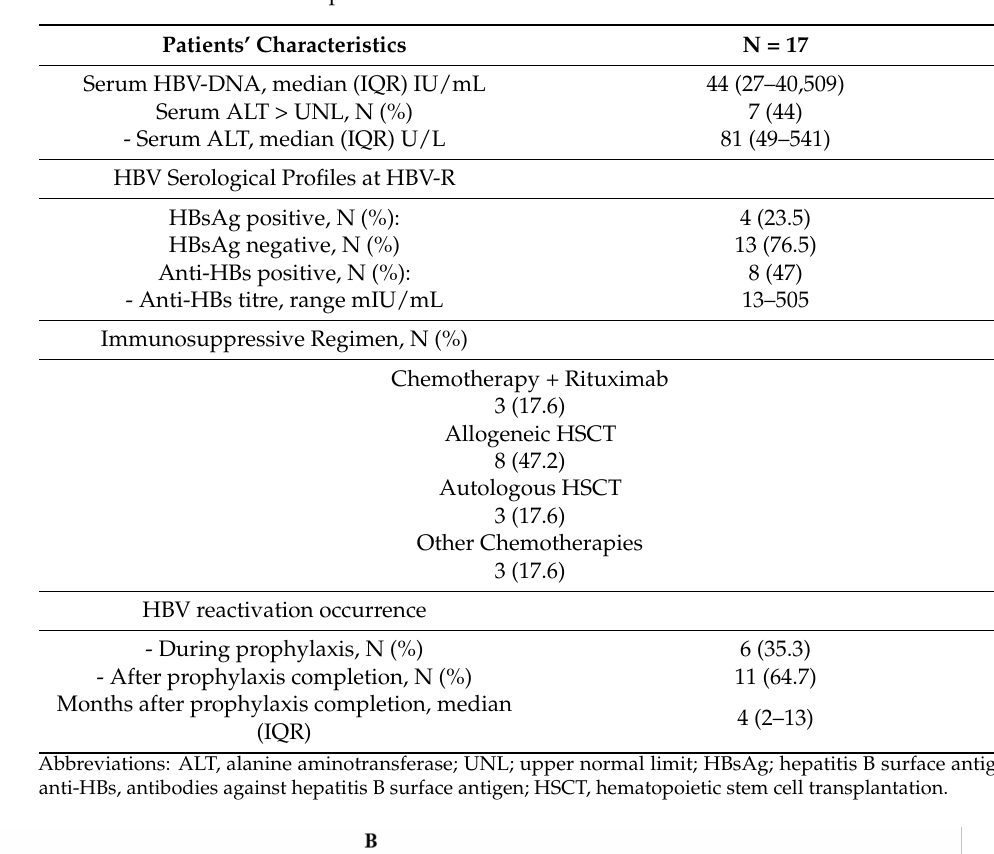
Table 2. Characteristics of 17 patients at HBV-R.